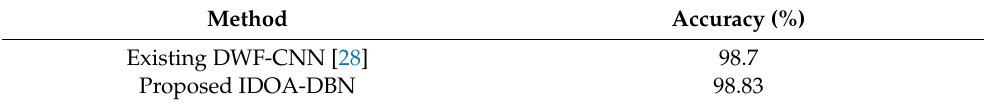
Table 5. Comparative analysis of accuracy with existing method.